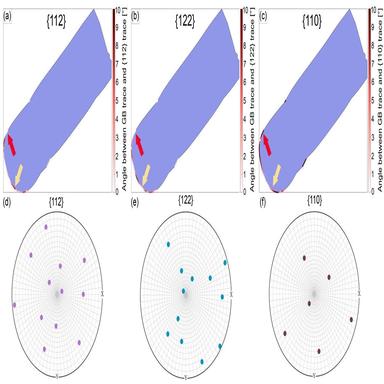
Angle of the traces of selected GB planes and the GB segments for (a) , (b) and (c) ; (d-e) respective pole figures that show the GB planes.